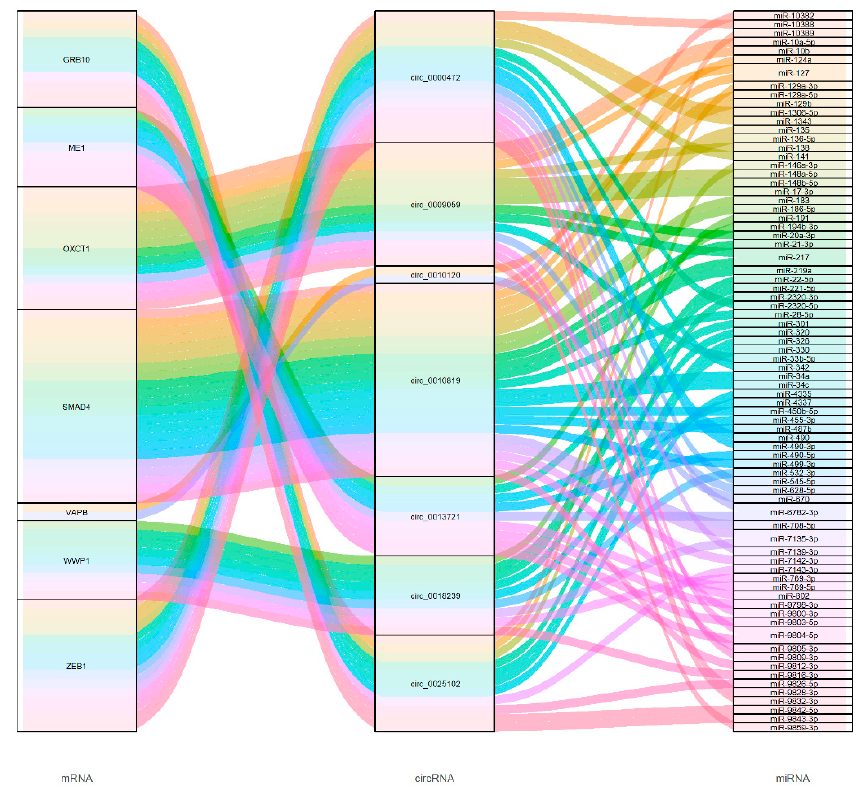
Figure 5. CircRNA network diagram for the source gene, DECs and their target miRNAs. Each rectangle represents a gene, and the connection degree of each gene is visualized based on the size of the rectangle.